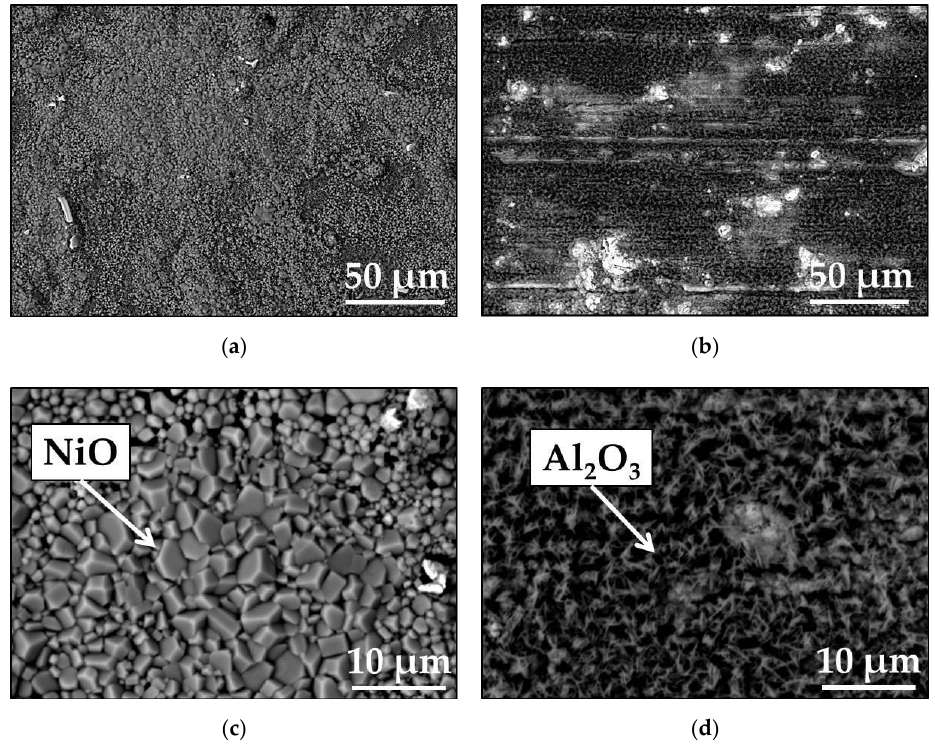
Figure 2. Scanning electron microscopy backscattered electron SEM/BSE images performed on surface of Mar M 247 after isothermal air oxidation test at 1000 °C up to 48 h showing oxide scale formed on: ( a ) polished up to 1 µm diamond paste taken at low magnification ( a ) and high magnification ( c ); ( b ) ground using 80 grit sand paper taken at low ( b ) and high magnification ( d ).